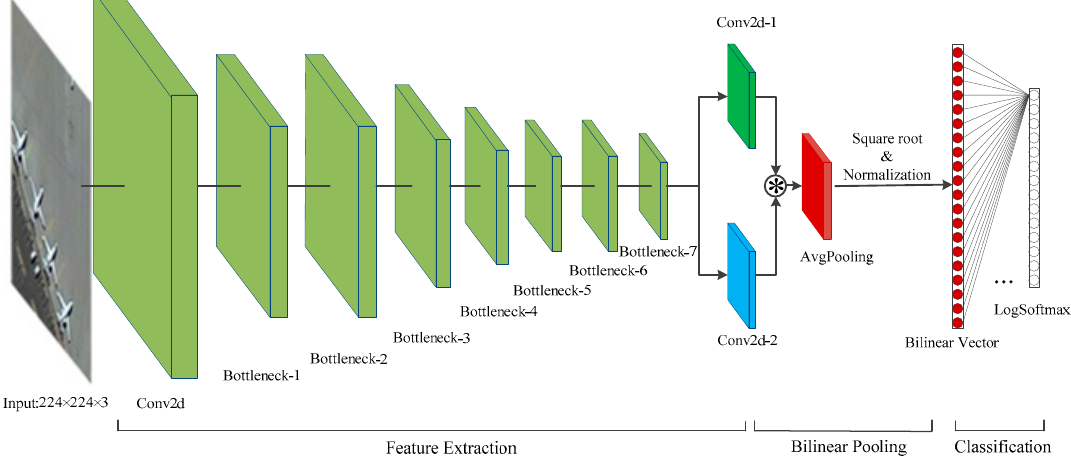
Figure 8. Architecture of BiMobileNet. See text for description.